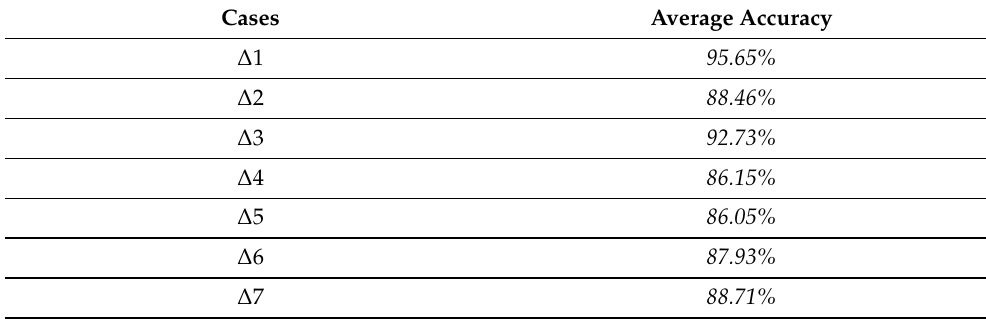
Table 3. Average accuracy of calculated ∆ 1 ∼ ∆